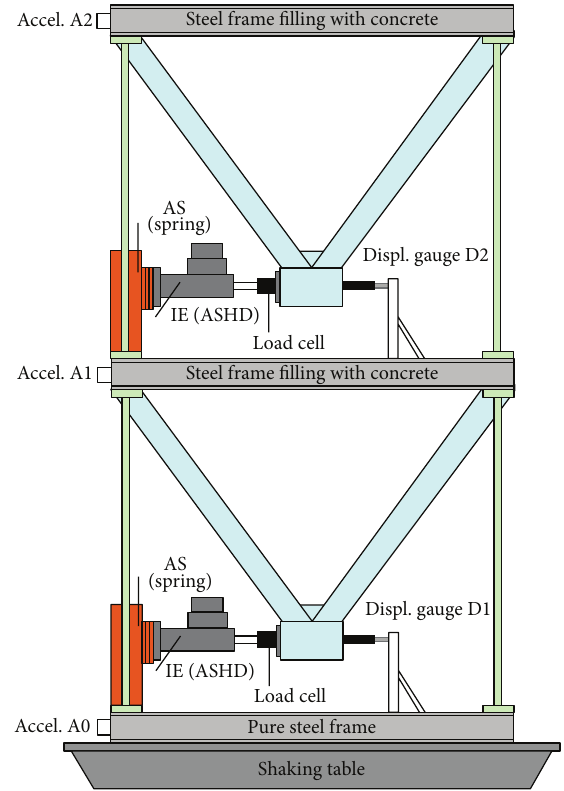
Figure 4: The full-scale shaking test structure added with IE, stiffeners, and sensors.